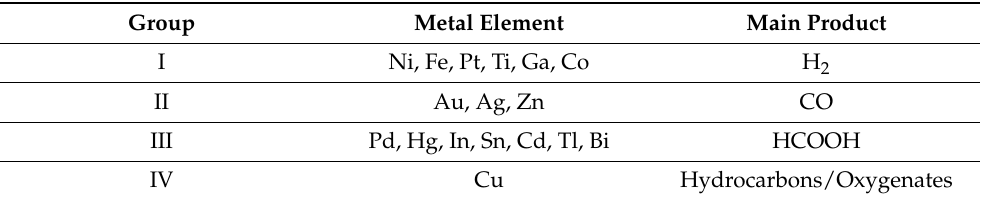
Table 1. Main products of CO 2 reduction reaction on different catalytic materials. Reprinted with permission from Ref. [29]. Copyright 2016,